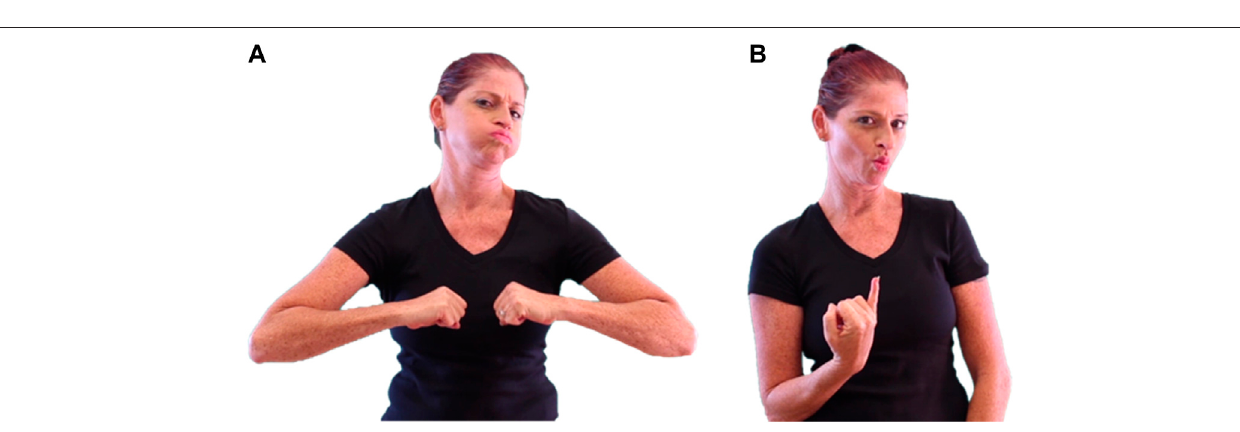
Frontiers in Communication |